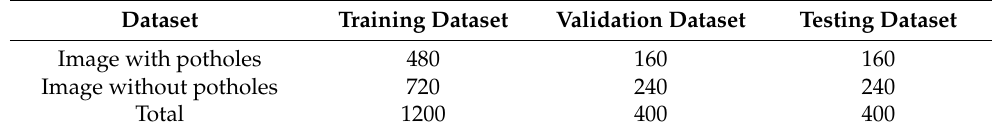
Table 2. Detailed division information of image dataset of pavement